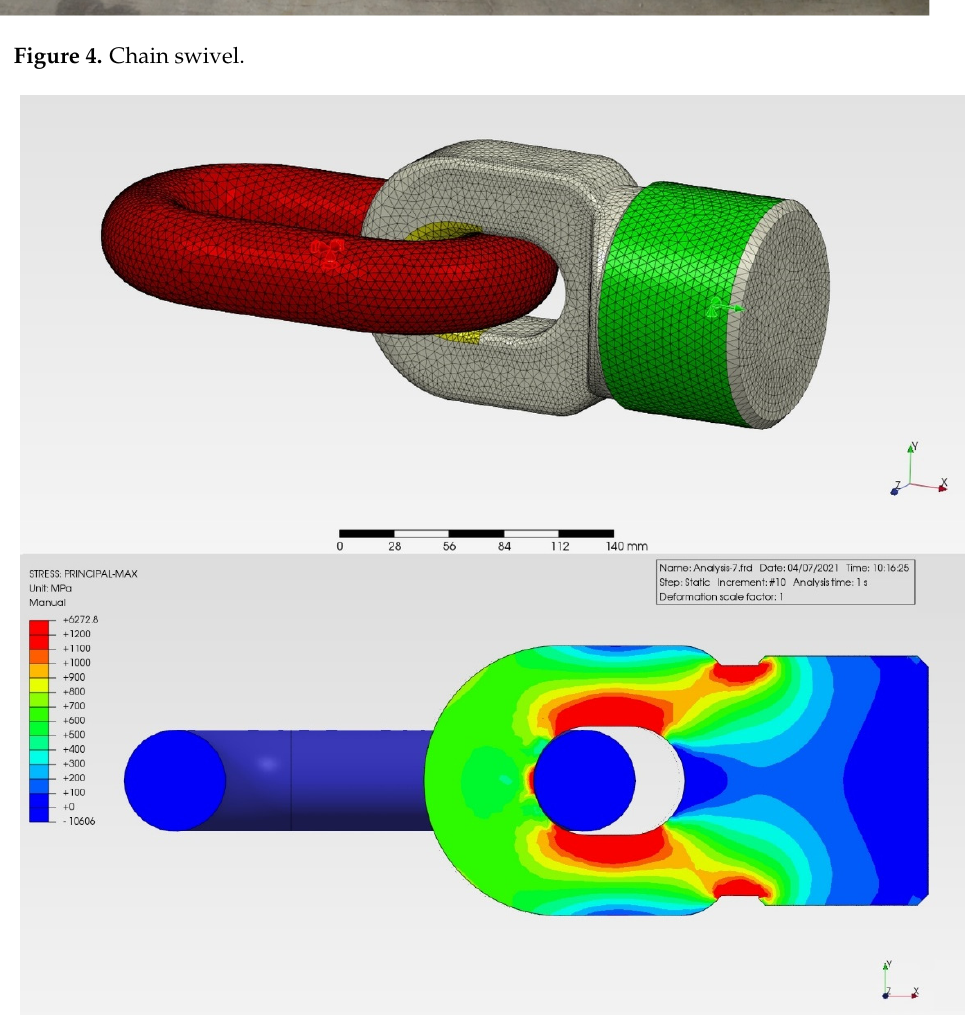
Figure 5. FEA determination of stress concentration.